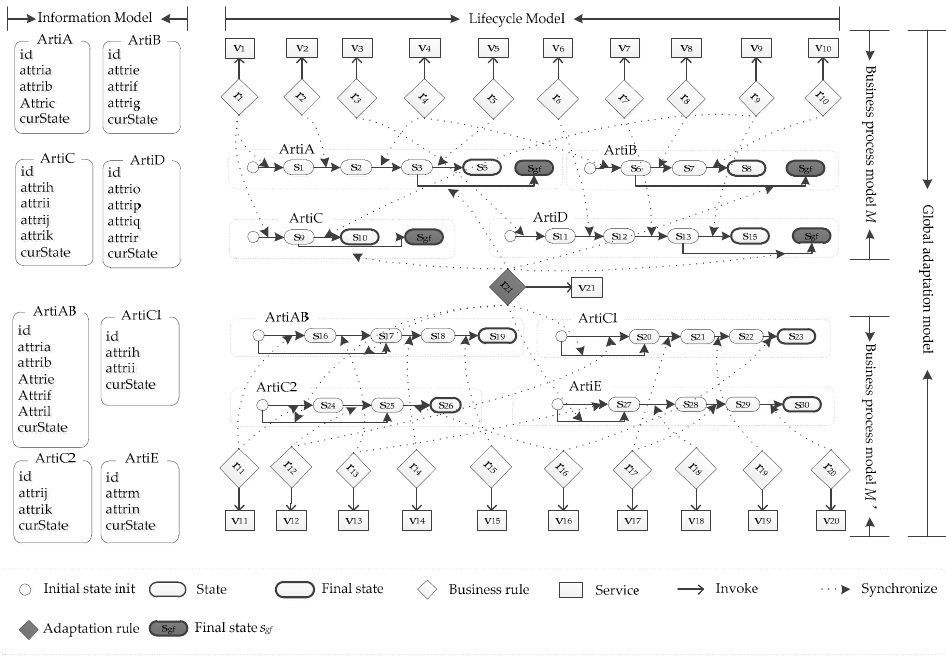
Figure 3. Artifact-centric representation of a global adaptation model.